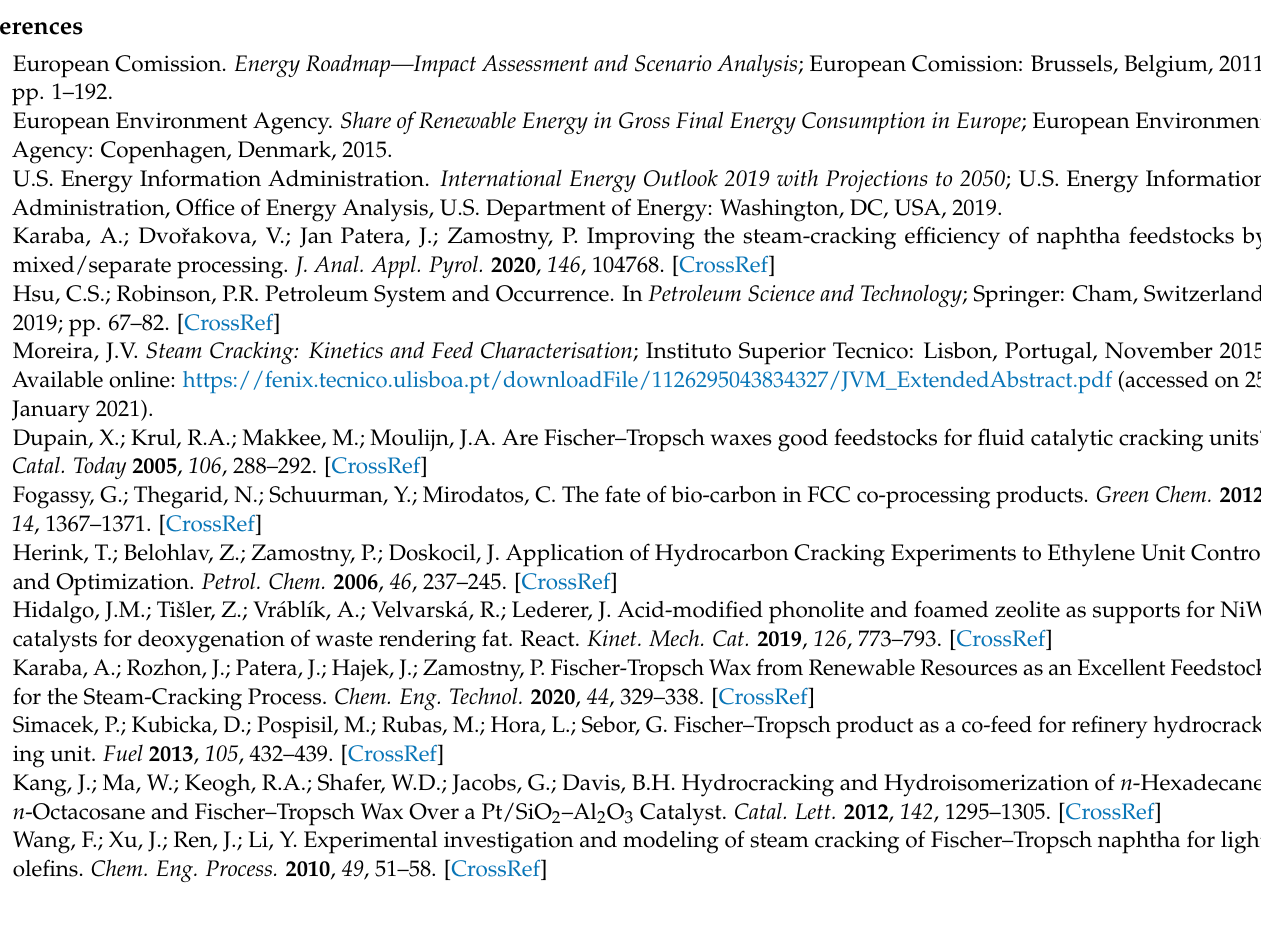
LED for RF; Figure S3: Pictures obtained using a microscope LEICA CM2500 LED for FTS; Table S1: Simulated Dis-tillation of the feedstock, rendering fat, HDO paraffins and FTS paraffins; Table